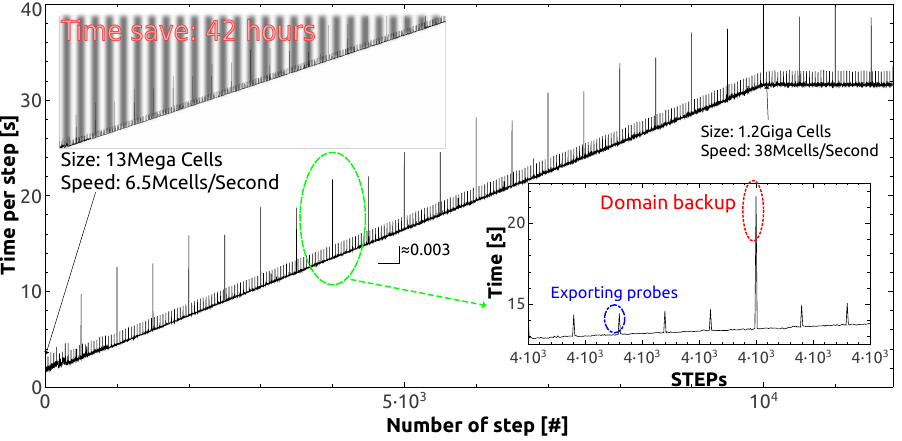
Figure 3. The figure shows the time per step in the simulation updating in a computational domain with dynamics limits (index k is a dynamical magnitude). Furthermore, the number of threads in the palatalization process is